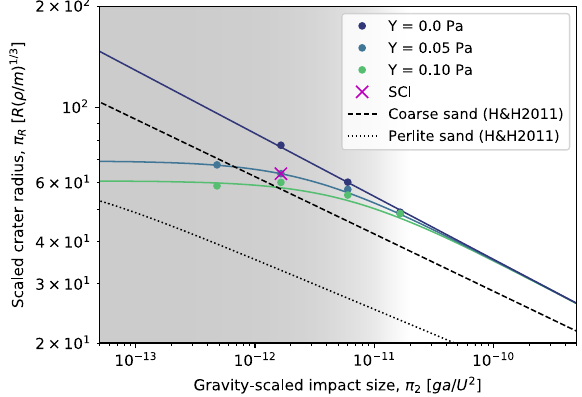
Fig. 4 | Impact outcome as a function of impact size. Shown is the scaled crater radius as a function of gravity scaled impact size for different target cohesions. Shown are the results of the simulations using a nominal coef fi cient of friction of f =0.55.Thescalingrelationshipsforcoarseandperlitesand(H&H2011;ref.44)are shown for comparison. The case with a cohesion of Y =0.05Pa leads to the best fi t with the observed SCI crater. Even small increases of the cohesion lead to sig- ni fi cantly smaller craters. The background gradient shows the transition between thestrengthandgravitydominated crateringregimes.Sourcedataareprovidedas a Source Data fi